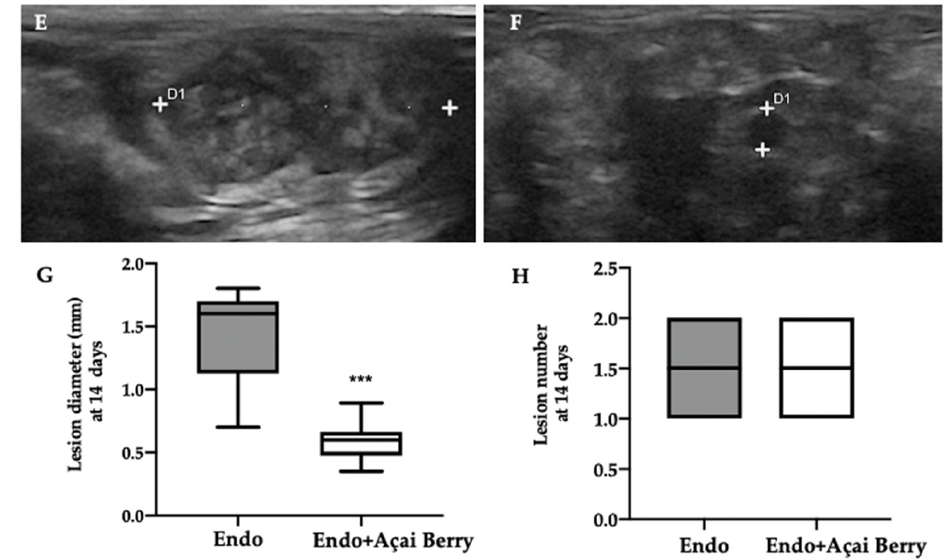
Figure 1. Analysis of endometriotic-like lesions development: High-frequency ultrasound analysis (hfUS) at 7 days from the endometriosis induction: Endo ( A ), Endo + Açai Berry ( B ), lesion diameter ( C ) and lesion number ( D ). hfUS analysis at 14 days from the endometriosis induction: Endo ( E ), Endo + Açai Berry ( F ), lesion diameter ( G ) and lesion number ( H ). A p -value of less than 0.05 was considered significant. *** p < 0.001 vs. Endo.